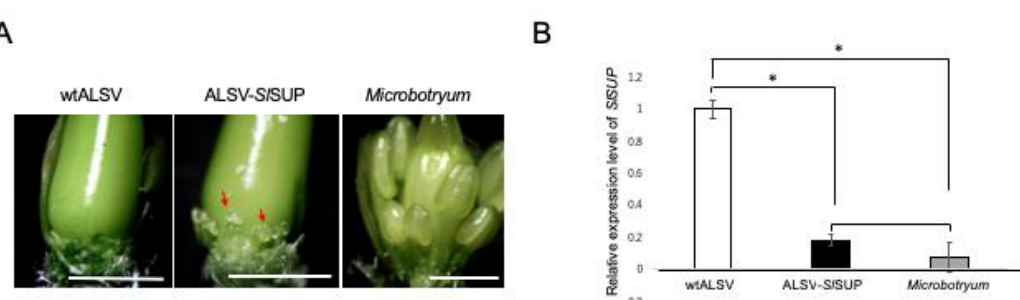
Figure 7. Downregulation of the SlSUP gene by VIGS in S. latifolia plants. ( A ) Different levels of stamen induction in female S. latifolia infected with wtALSV, ALSV- Sl SUP, and Microbotryum . Stamens are not developed in female flowers in the wtALSV plants, while marginally and fully developed stamens are observed in female flowers in ALSV- Sl SUP- and Microbotryum -infected plants, respectively. Red arrows indicate the stamens in ALSV- Sl SUP plants. Bars = 1 mm; ( B ) RT-qPCR analysis of SlSUP gene expression levels in the female flower meristems infected with wtALSV, ALSV- Sl SUP, and Microbotryum . Five flower meristems corresponding to stage 7–10 were collected, and the stamen induction was checked under a microscope in ALSV- Sl SUP- and Microbotryum -infected plants. Two out of five buds had confirmed stamen induction in ALSV- Sl SUP plants. All buds had confirmed stamen induction in Microbotryum -infected plants. The error bars represent the standard deviations at those two buds, normalized to the S. latifolia ubiquitin 11 gene. Asterisks indicate a significant difference; there was no significant difference between plants infected with ALSV- Sl SUP and Microbotryum at p < 0.05 (Student’s t -test).